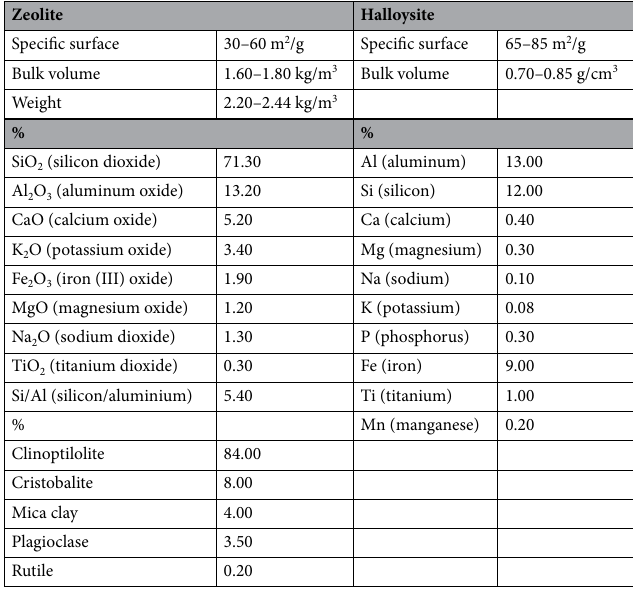
Table 1. Characteristics and chemical composition of halloysite and zeolite (supplier